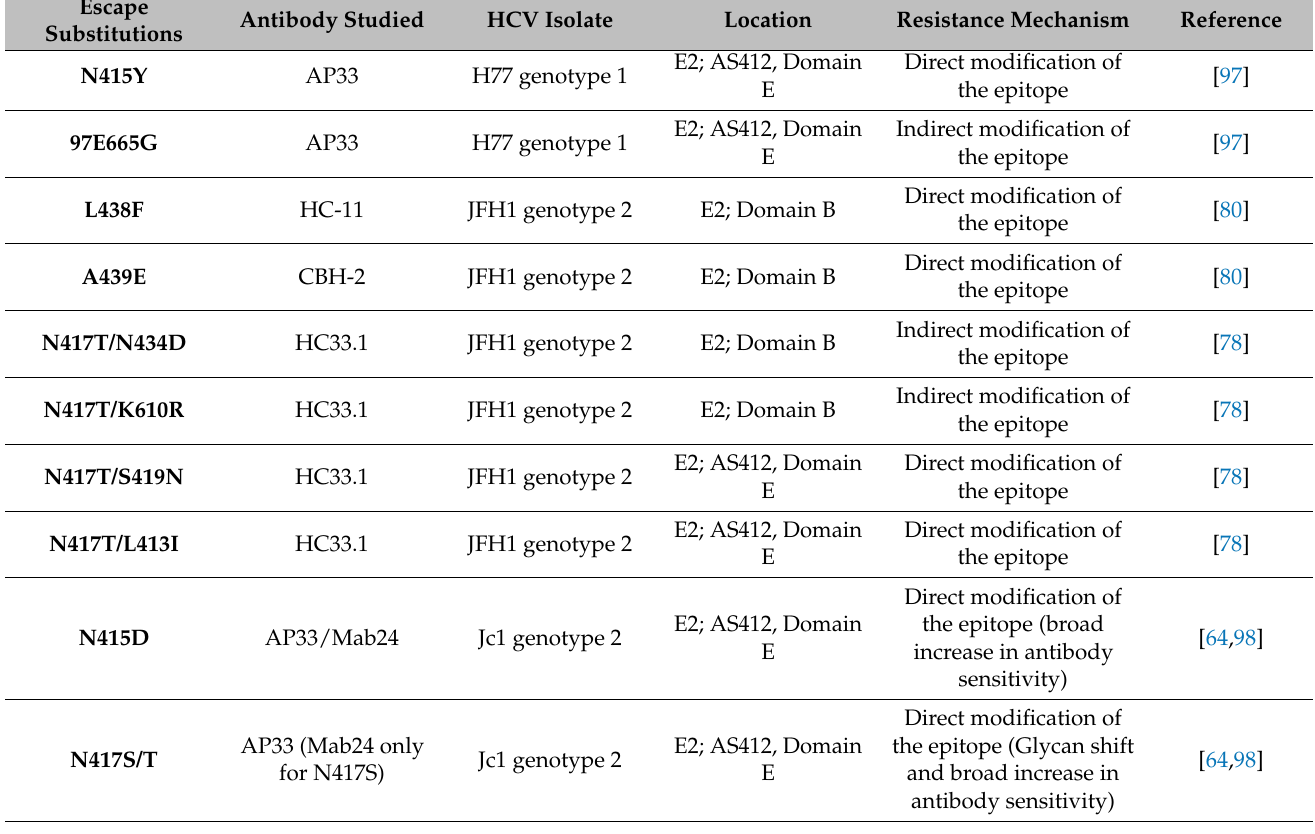
Table 1. Advancements in the study of HCV antibody